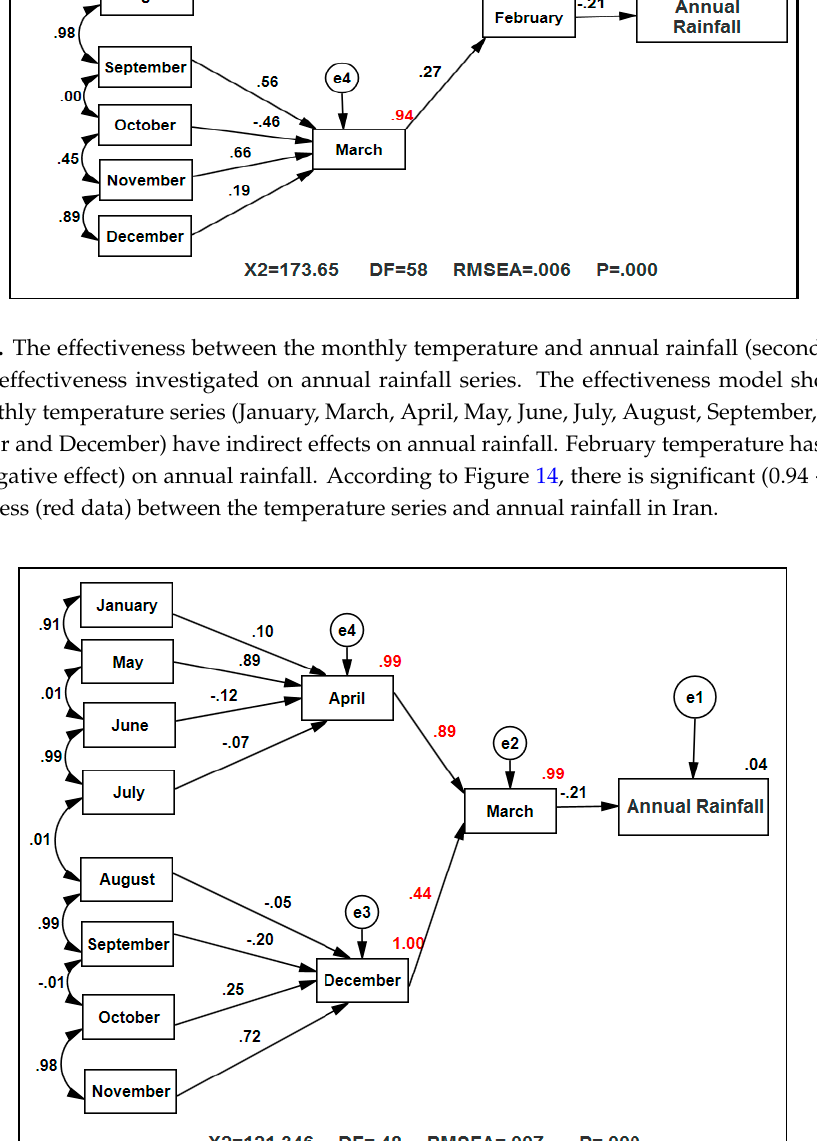
Figure 14. The effectiveness between the monthly temperature and annual rainfall (second model). Monthly effectiveness investigated on annual rainfall series. The effectiveness model shows that nine monthly temperature series (January, March, April, May, June, July, August, September, October, November and December) have indirect effects on annual rainfall. February temperature has a direct effect (negative effect) on annual rainfall. According to Figure 14, there is significant (0.94 < R 2 < 1) effectiveness (red data) between the temperature series and annual rainfall in Iran.